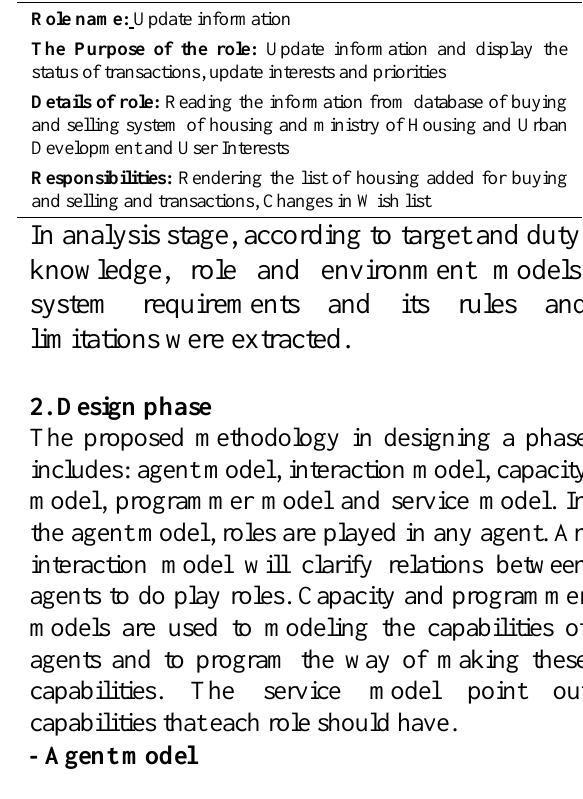
Table 9. Role model for the role of use licenses.